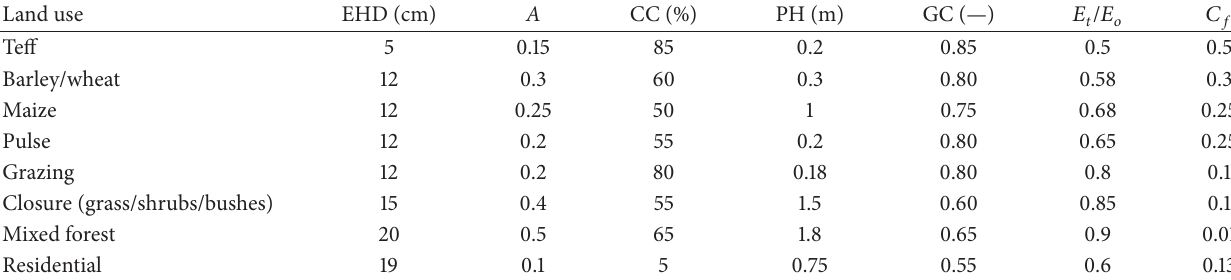
Table 1: Plant related hydrological parametersfor different land use and land cover in the Mai-Negus catchment.